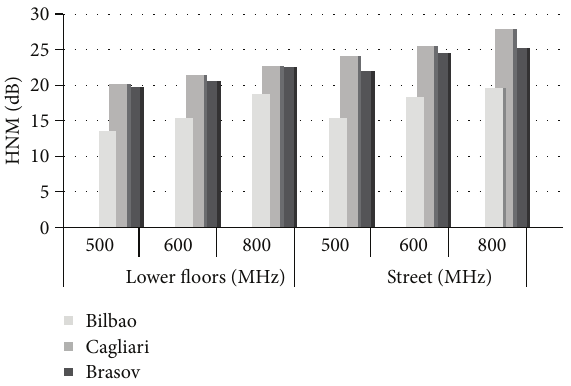
Figure 7: HNM for the three cities in suburban environment.